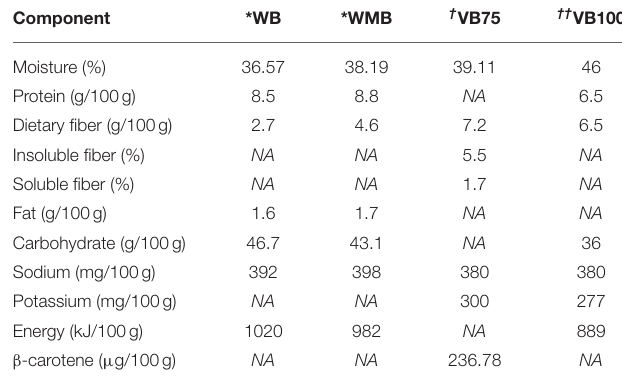
TABLE 1 | Recipe formulation for bread development. Ingredient VB75